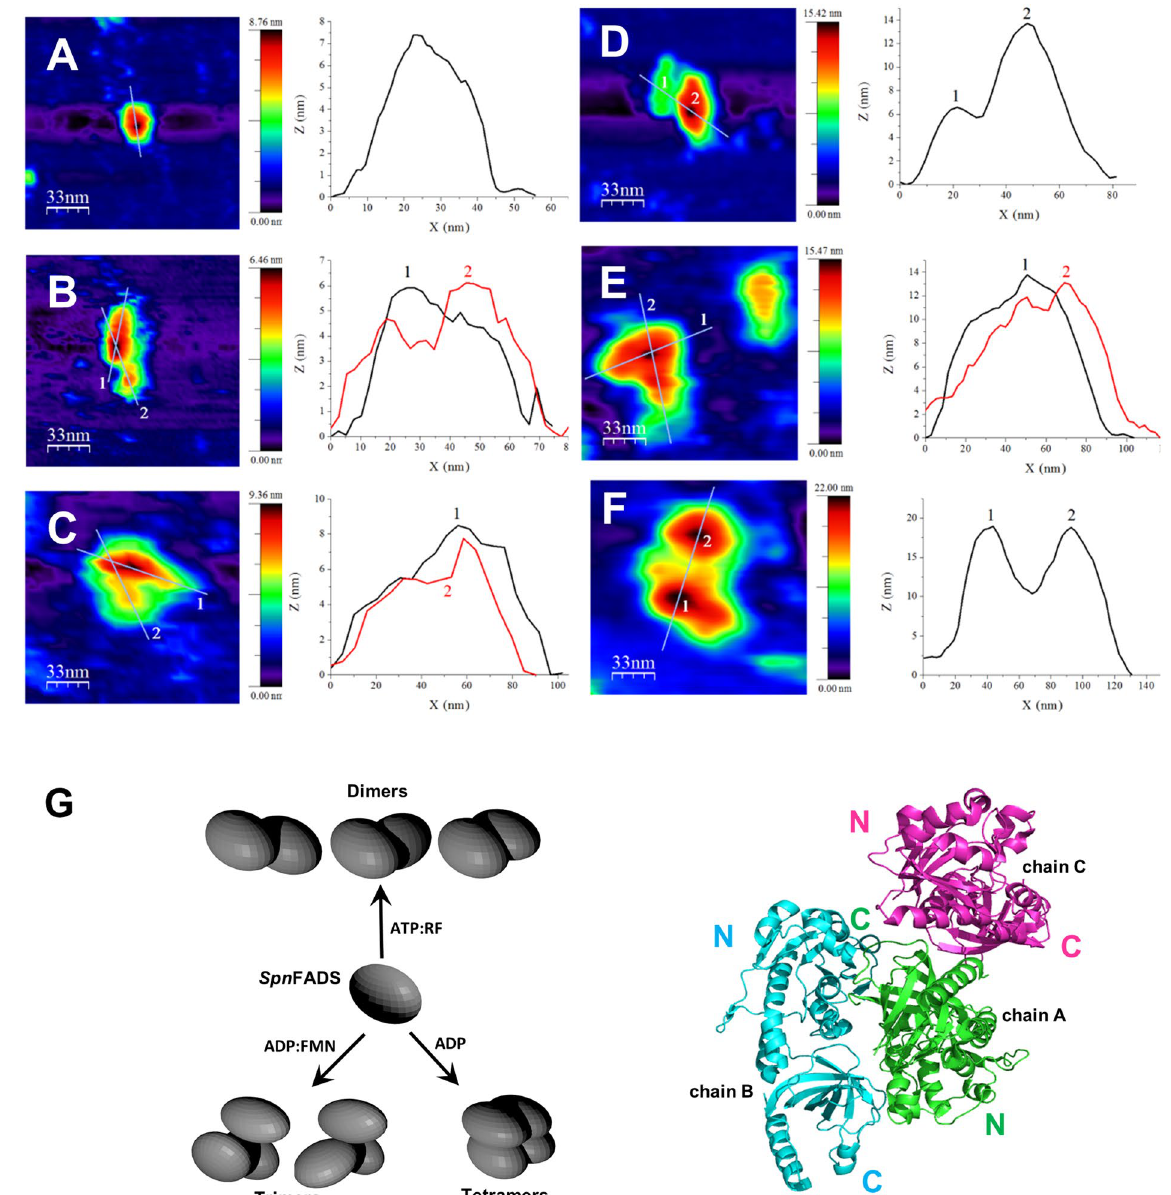
Figure 4. Image analysis of Spn FADS assemblies. Topography AFM images of a scanned area of 167 × 167 nm and Z-height profiles associated to the lines on the features of Spn FADS samples. ( A ) Monomer. ( B ) Dimer on the same plane. ( C ) Dimer with an overlapping on a monomer on the other. ( D ) Trimer from ( B ) showing an overlapped dimer interacting with a monomer. ( E ) Trimer from ( C ) showing overlapping of the dimer on a monomer. The different sizes of the original scanned images slightly change the roughness of the surface and the lateral resolution. This affects the size of the features in X-Y but not the Z-height measured in the profiles. ( F ) Tetramer. ( G ) Blender simulation of different assemblies according to the presence or absence of ligands and assembly of the three Spn FADS molecules in the crystal asymmetric unit (PDB ID: